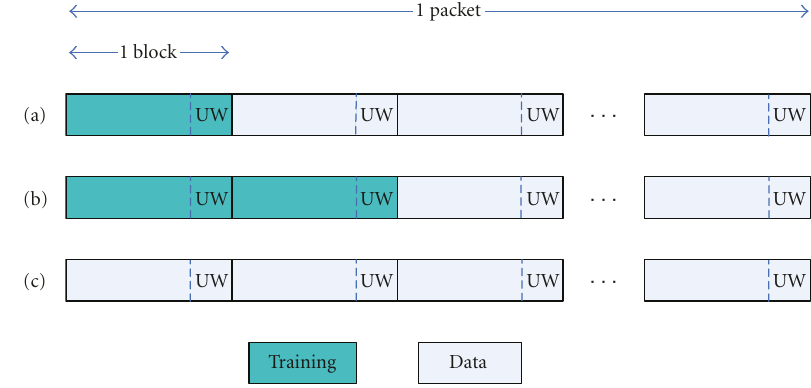
Figure 7: Illustration of packet format for MIMO UW simulations with puncturing: (a) 1 preamble, (b) 2 preambles, and (c) UW only.